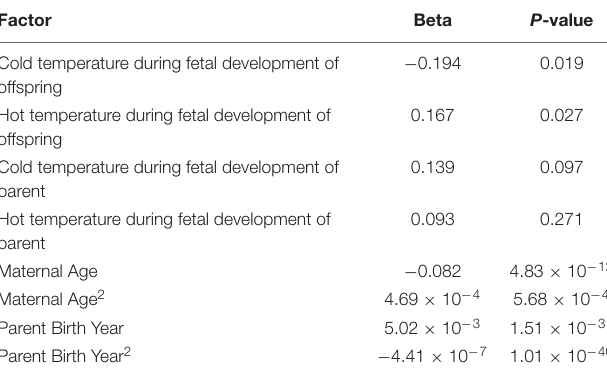
TABLE 1 | Results of the mixed model analyses of eight factors related to the recombination rates in